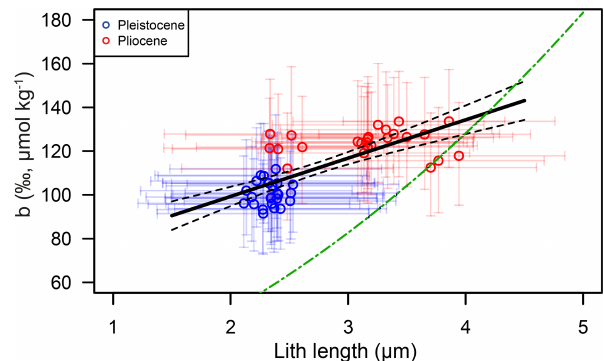
Figure 11. Comparison between the posterior distribution for the Pliocene (red circles) and Pleistocene (blue circles) and the lith size correction of Henderiks and Pagani (2007) (green dot–dash